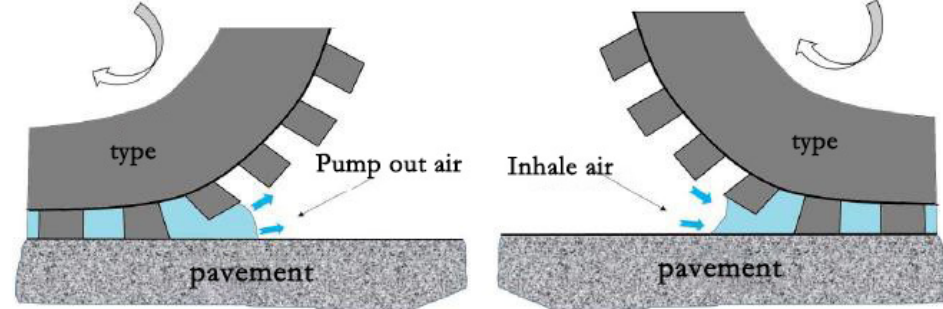
Figure 2. Air pumping